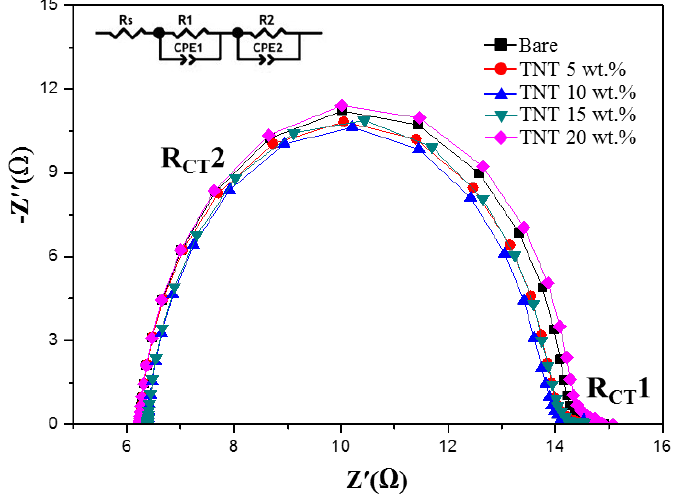
Figure 5. I – V characteristic of TiO